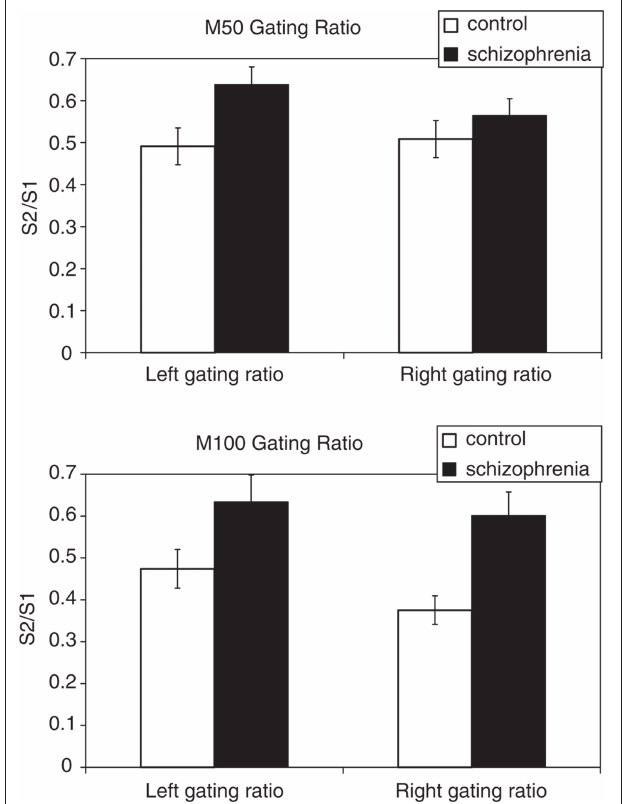
Figure  | Auditory sensory gating responses (indexed as a ratio in sensor power between the response to the second (S) and first (S) auditory click) in both patients with schizophrenia and controls. Auditory gating ratios at both 50 ms (M50) and 100 ms (M100) following stimulus presentation are significantly greater in the patient group in the left hemisphere. In the right hemisphere, reduced sensory gating in the patient group was only significant for a M100 response. Error bars = SE mean. Reproduced, with permission, from Hanlon et al.